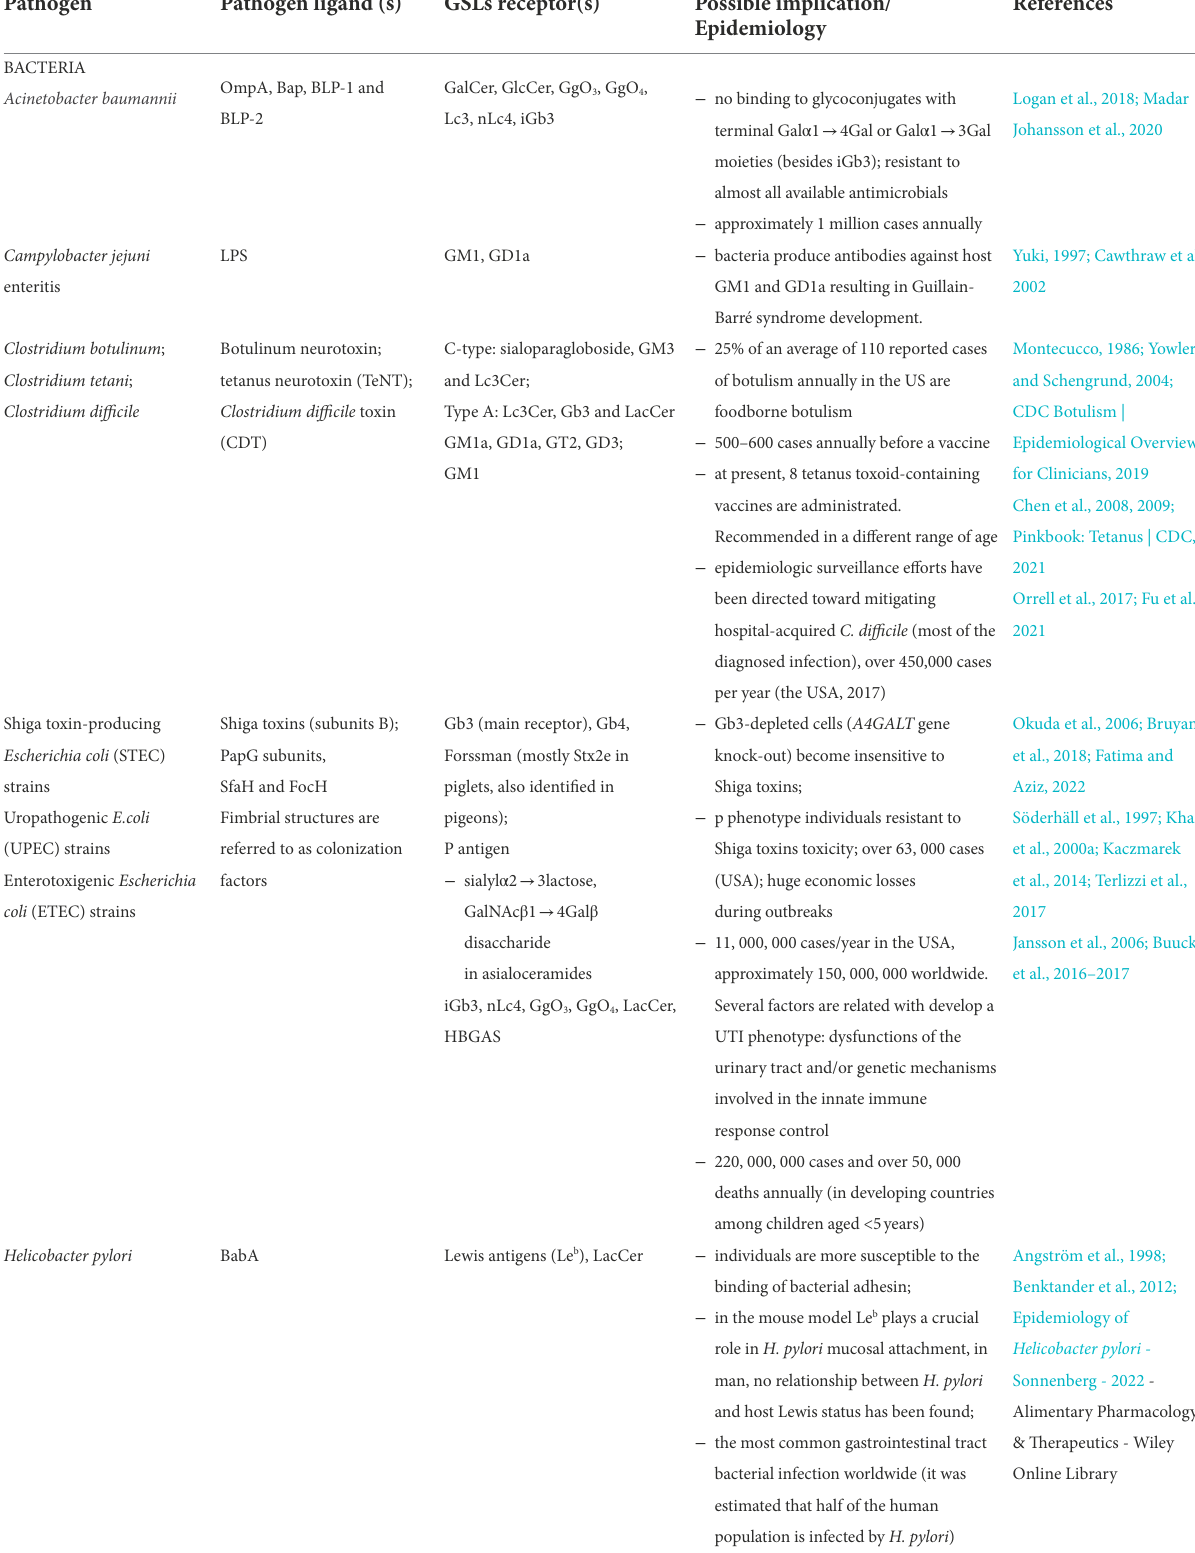
TABLE 1 Summary of described pathogen ligands, host receptors and relevance of these interactions in infectious diseases